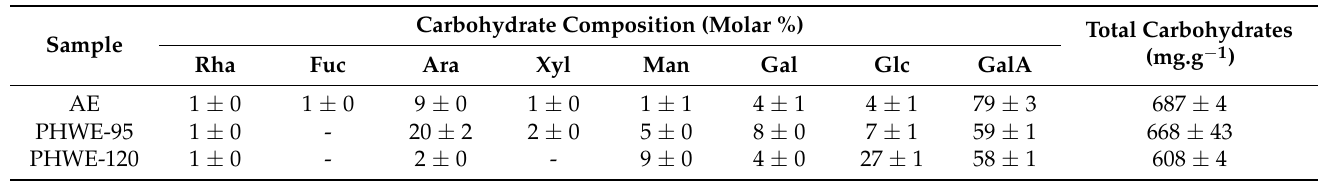
Table 2. Yield, total carbohydrates, and monosaccharide composition (molar %) of polysaccharide–polyphenol conjugates (AE, PHWE-95, PWWE-120). Results are expressed as mean values ± standard deviation.